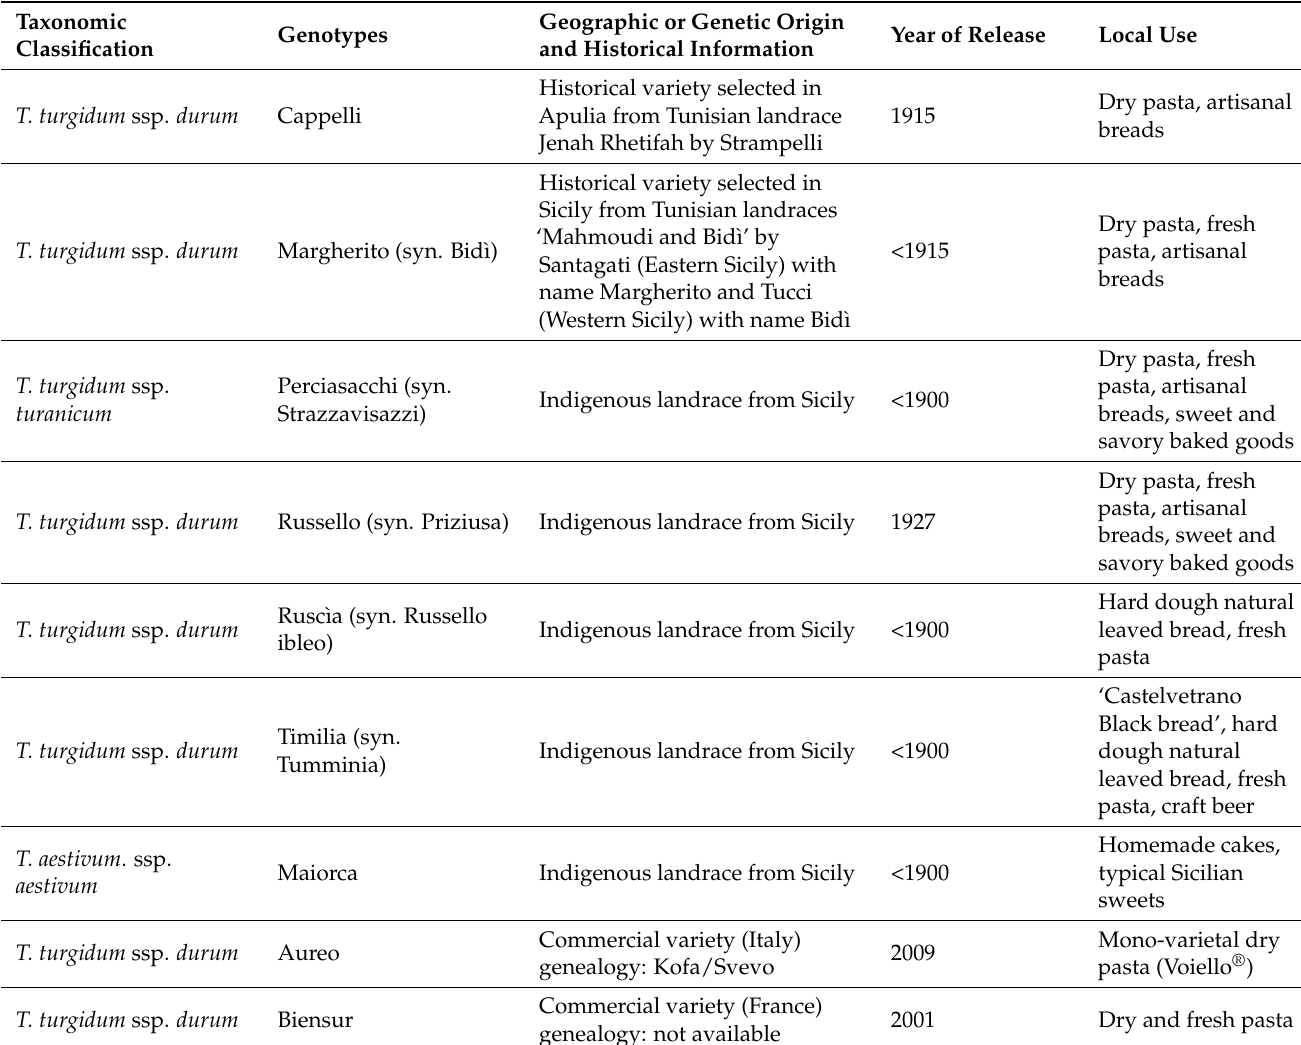
Table 1. Taxonomy, origin and main local uses of Sicilian wheat landraces/historical and commercial varieties analyzed in this